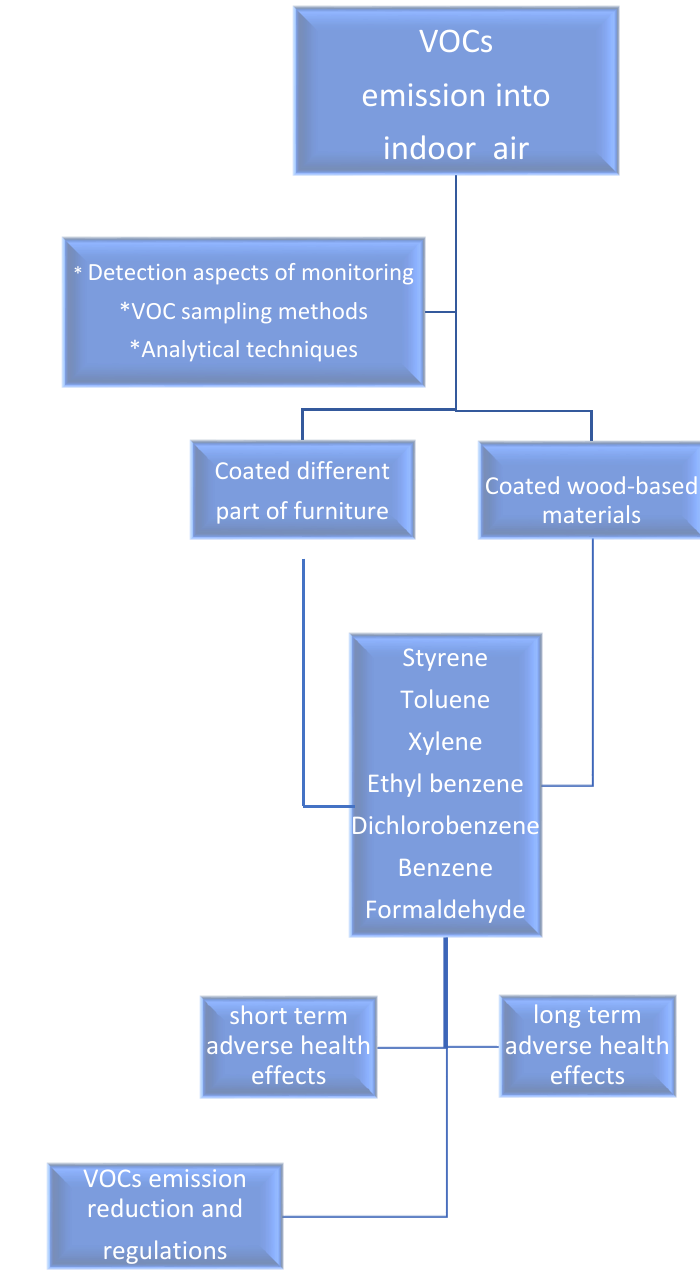
Figure 1. The literature search strategy of the review.